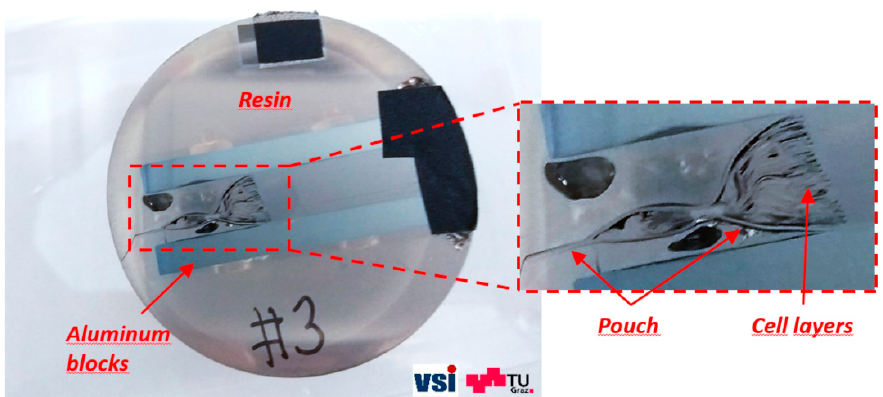
Figure 4. Dry-polished layer stack structure used for identification of cell-specific parameters and layer arrangements. The presented sample was generated from the side of battery that was opposite to the battery tabs.